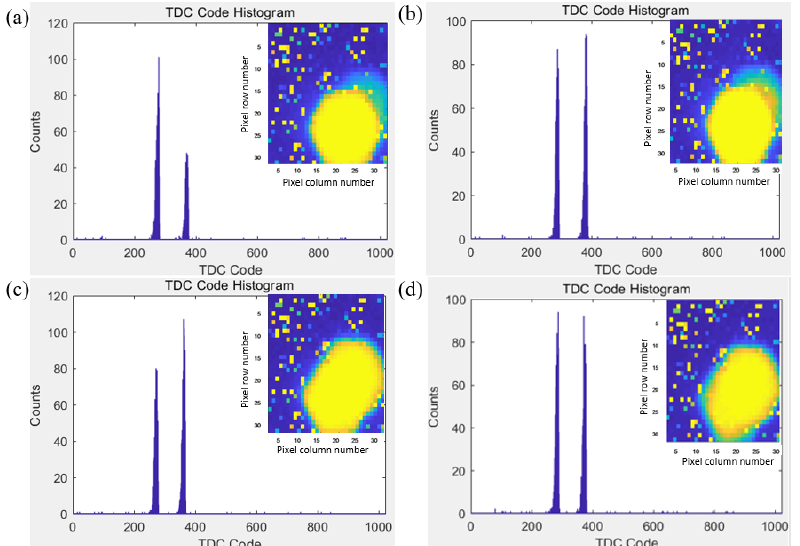
Figure 4. ( a – d ) Simulation diagram of simultaneously obtaining two distances based on time coding.